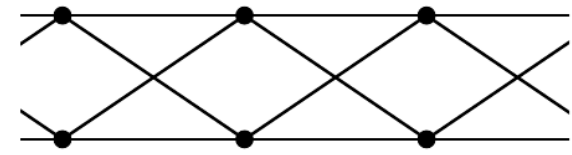
Fig. 2. A four-wire Hoytether. Wire bonding sites are shown by